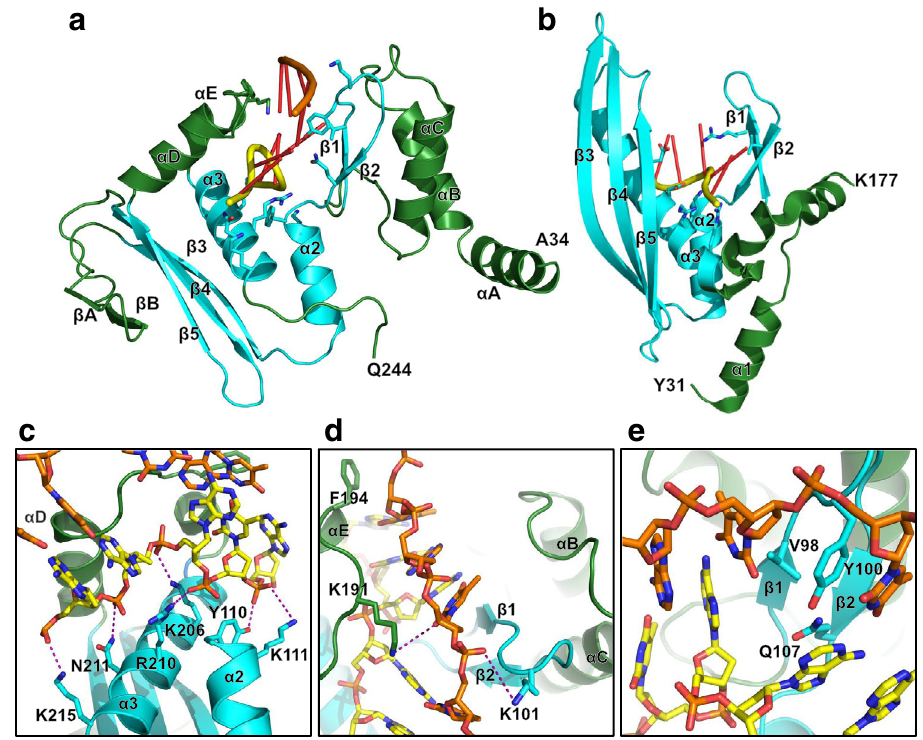
Fig. 3 | Structure of the LiRecT monomer, comparison with RAD52, and inter- actions with DNA. Monomers of LiRecT ( a ) and RAD52 ( b ) are shown in similar orientations with their common core folds in cyan and extraneous segments in green.The DNAbackbonesaredrawnwiththeinnerstrand in yellow andtheouter strand in orange (for LiRecT only). The DNA binding groove is formed by the 2